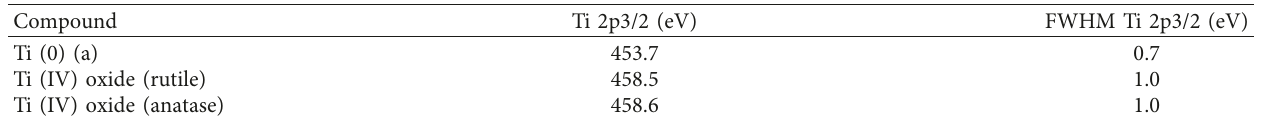
Table 3: Literature values for band energy of Ti 2p3/2